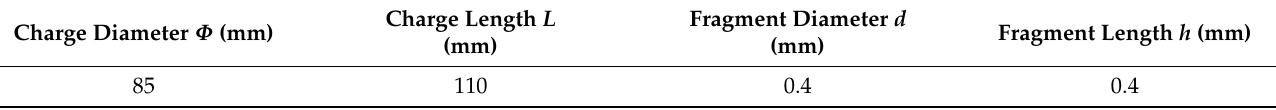
Table 2. MAT_NULL material model and EOS_LINEAR_POLYNOMIAL parameters of the air [26].